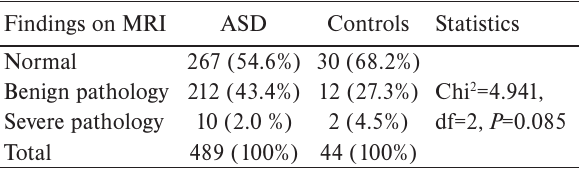
Table 1. Categories of MRI findings. Findings on MRI